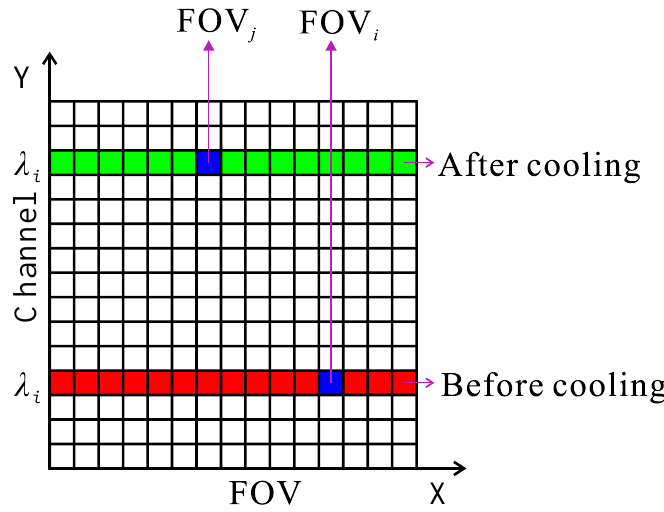
Figure 4. The change in focusing FOV position before and after